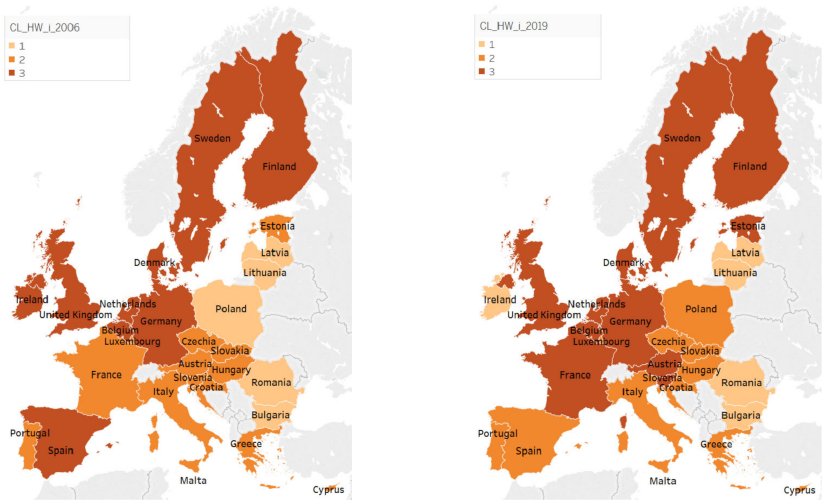
Figure 2. Clusters of human wellbeing components in 2006 vs. 2019. Source: SSI database, computed in Tableau Public v.